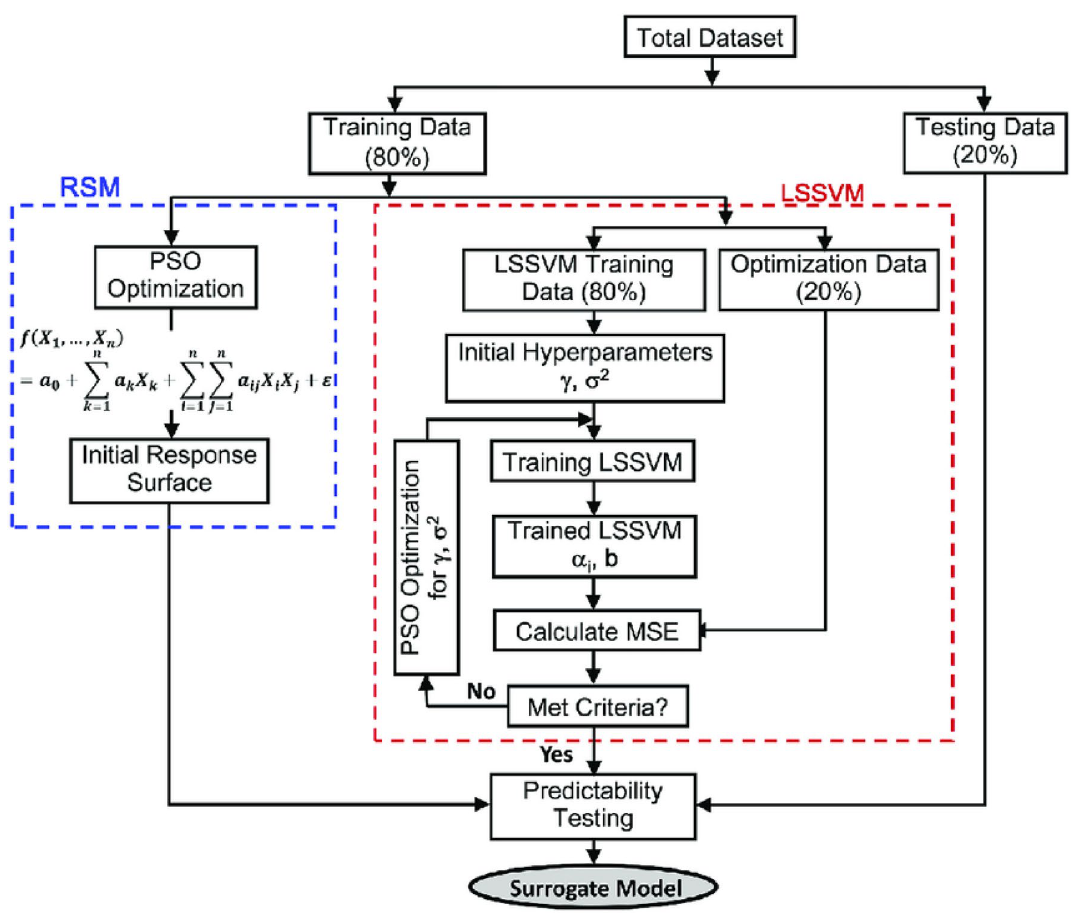
Fig. 7 Workflow used to develop RSM and LSSVM (Sukhadia et al.